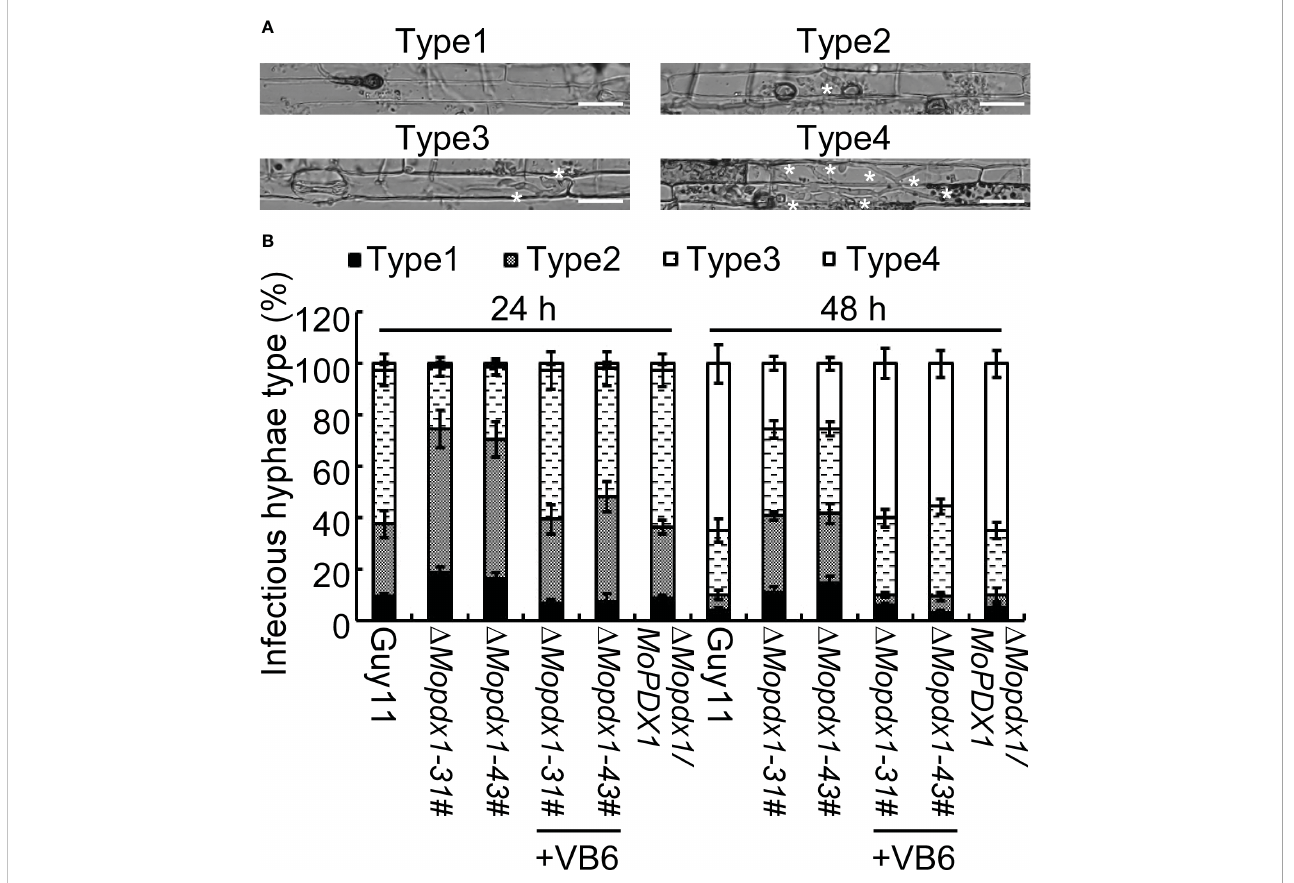
FIGURE 5 Deletion of MoPDX1 attenuates the growth of infectious hyphae in rice sheath cells. (A) Four types of infectious hyphae (IH) of M. oryzae in rice sheath cells. Type1 has no penetration; type 2 only has penetration peg or a single infectious hypha (IH); type 3 has more than two IH in one rice cell; type 4 has extensive IH into adjacent rice cells. White asterisks indicate IH in rice sheath cells. (B) Statistical analysis of the growth of IH in rice cells at 24 and 48 hpi with or without 10 -4 mg/mL of VB6 treating the conidial suspensions of MoPDX1 deletion mutants. One hundred IH were counted in rice cells infected with conidia suspensions of the indicated strains. Error bars represent the standard deviation. The experiments were repeated three times with similar